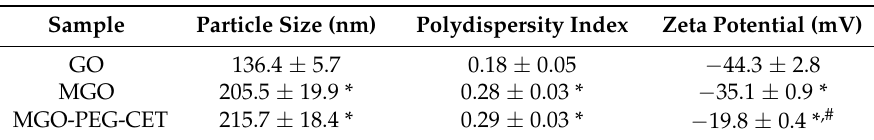
Table 1. The particle size and polydispersity index (PDI) by dynamic light scattering (DLS) and zeta potential of different nanocarriers.